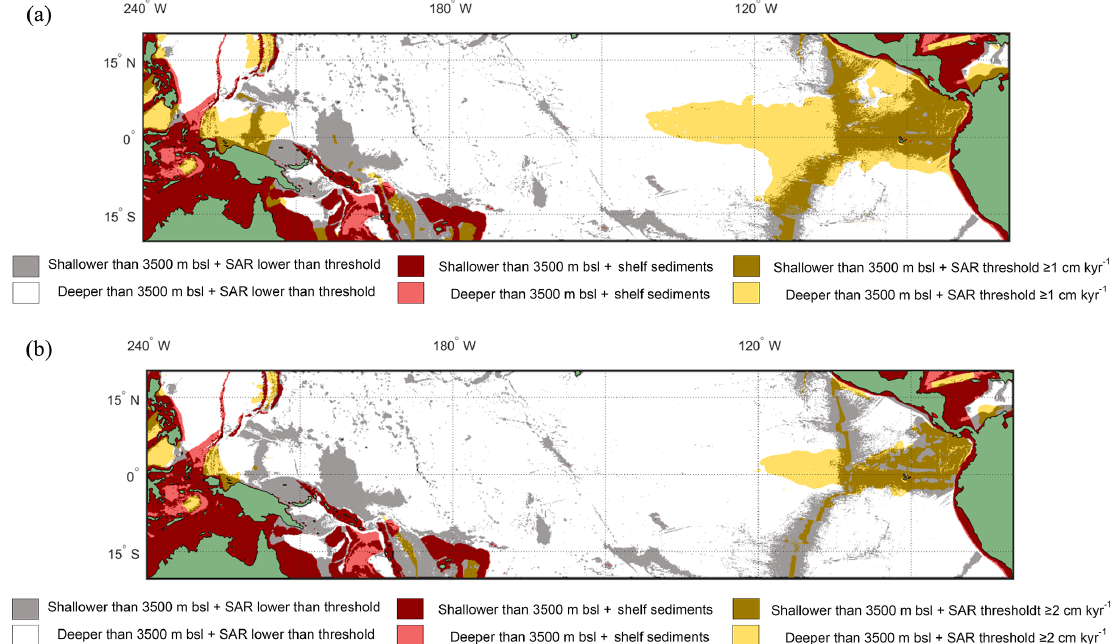
Figure 7. Overlay between water depth and inferred SAR (Olson et al., 2016). Cut-off limits for bathymetry and SAR are 3500 m below sea level and (a) ≥ 1cmkyr − 1 and (b) ≥ 2cmkyr − 1 respectively. The colours represent the following: red/pink: continental shelf sediments that are (red) shallower or (pink) deeper than 3500mb.s.l.; grey/white: grid point SAR is lower than SAR threshold and the seafloor depth is (grey) shallower or (white) deeper than 3500mb.s.l.; light yellow/gold: light yellow represents areas where the SAR is above the threshold, but the water depth is deeper than 3500mb.s.l., while in comparison gold represents areas where the SAR is above the threshold and the water depth is shallower than 3500mb.s.l. The ideal locations are therefore plotted as